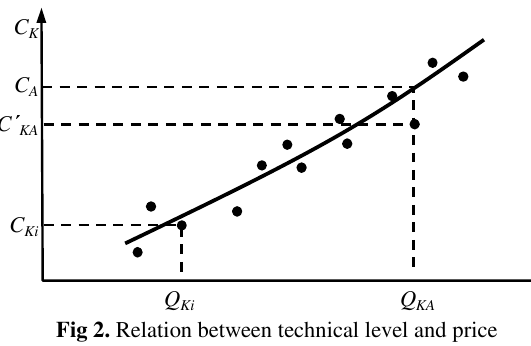
Fig 2. Relation between technical level and